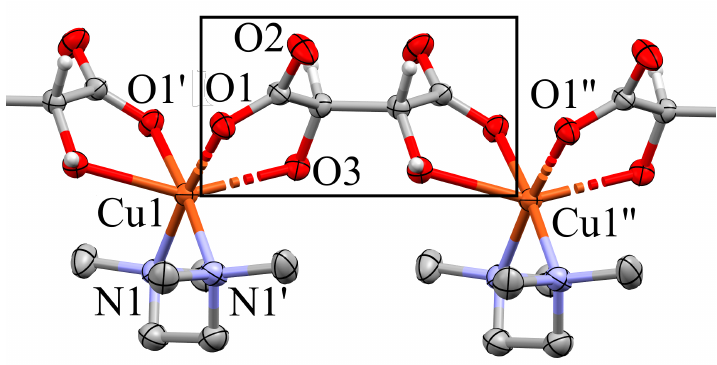
Figure 10. Section of a homochiral chain in 2c (Mercury, [42]); H atoms in the tetramethylethylenediamine (TMEDA) ligand have been omitted. Non-hydrogen atoms in the complex are shown as ellipsoids (70% probability), H as spheres with fixed radius of 0.15 Å. Coordination distances (Å): Cu1–O1 = 1.9740(14), Cu1–O1 (cid:48) = 1.9740(14), Cu1–N1 = 2.0557(16) Cu1–N1 (cid:48) = 2.0557(16), Cu1–O3 = 2.364(2), Cu1–O3’ = 2.365(2). Symmetry operators: ( (cid:48) ) = 3/2 − x , 3/2 − y , z ; ( (cid:48)(cid:48) ) = x − 1, y , z